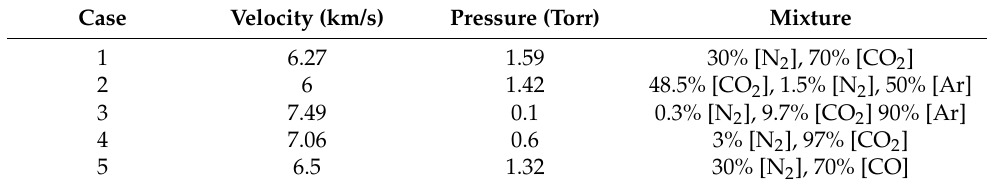
Figure 54. Left: Spectrum of C 2 for Swan bands ( ∆ v = 0 and ∆ v = +1) for Case 2 of Table 5–Right: Time profile of C 2 for Swan bands ( ∆ v = 0 and ∆ v = +1) for same conditions (from [54]). Table 6. Tests carried out in VUT-1 for Mars entry.